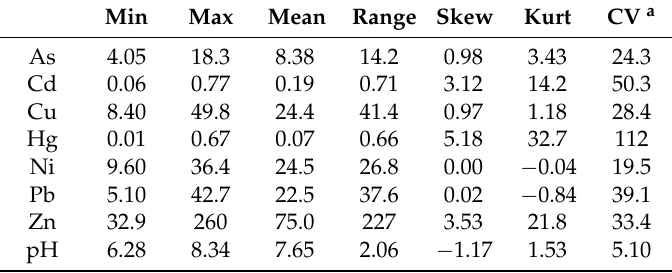
Table 1. Basic descriptive data of heavy metals in agricultural soils in the Beijing. Min Max Mean Range Skew Kurt CV